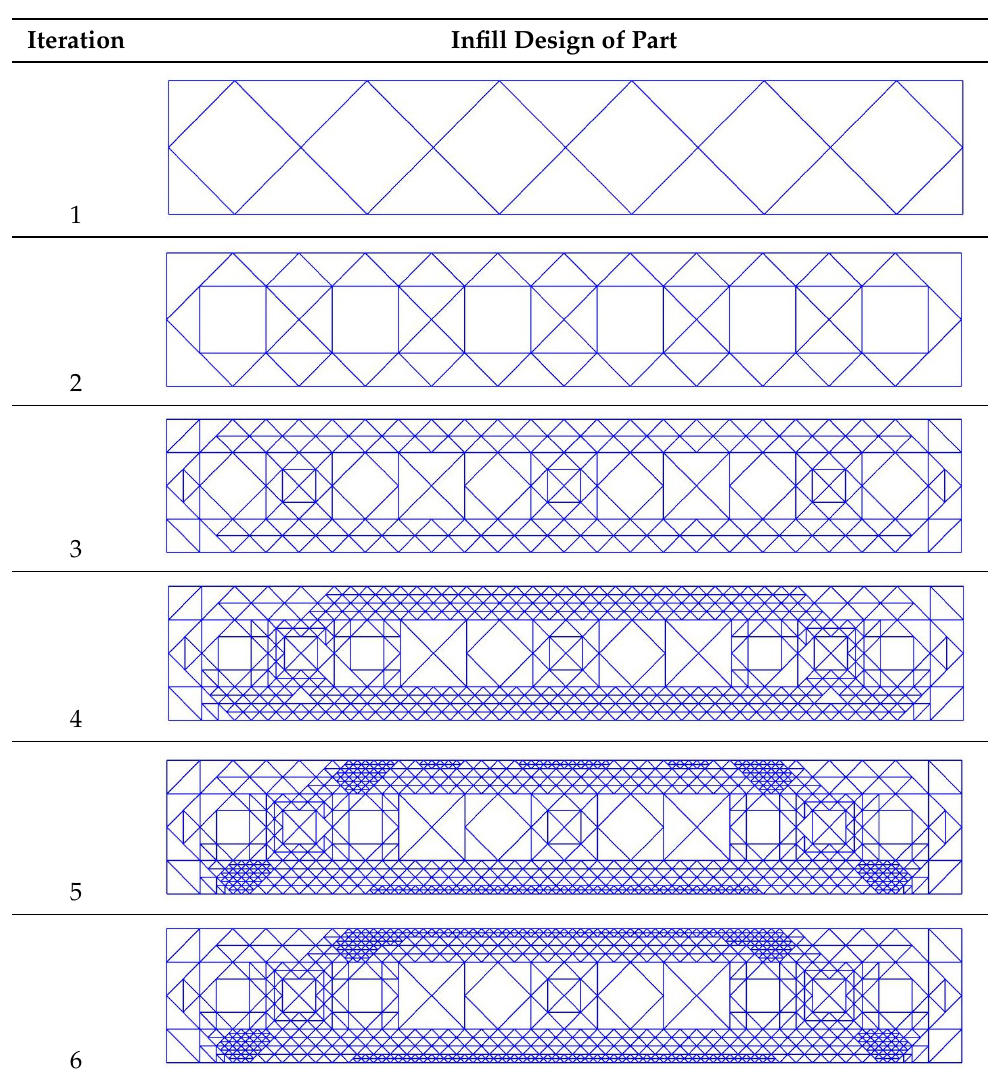
Table 1. Evolution of part infill design when subjected to a 4-point bending using